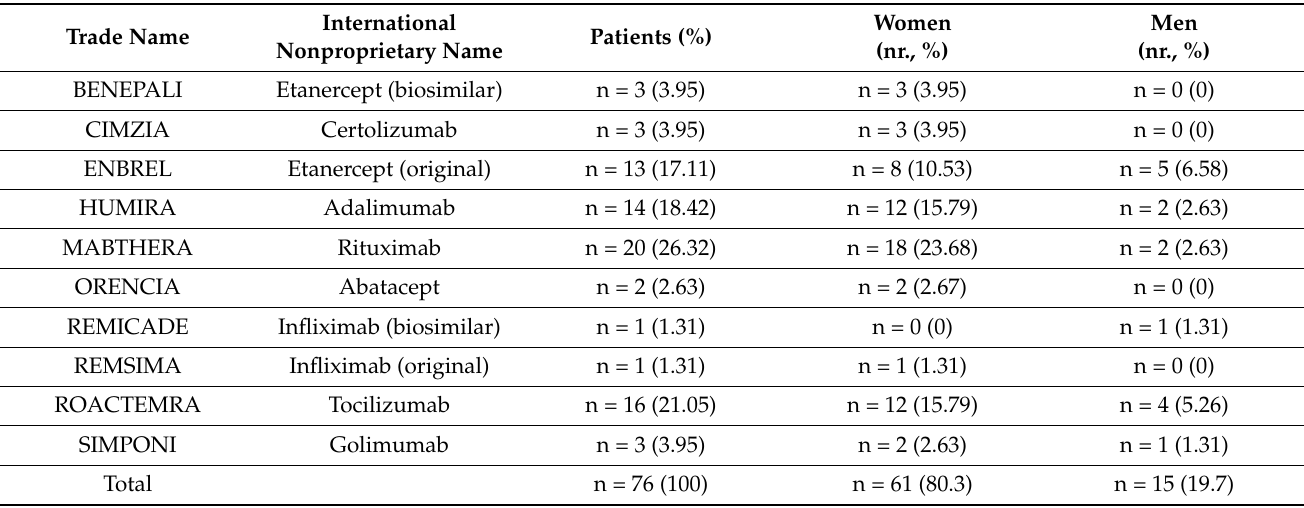
Table 2. Distribution of RA patients by gender and the biological therapy followed at the time of inclusion in the study.